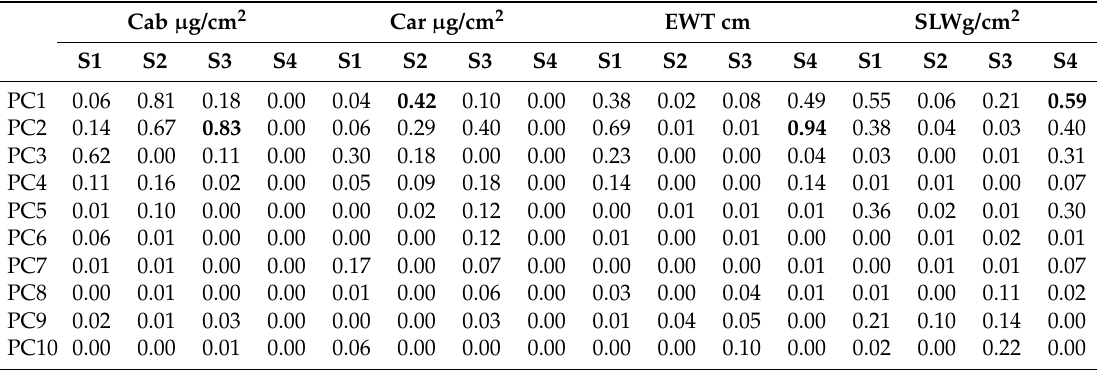
Table 4. The coefficients of determination between the weighting coefficients of the principal components (PCs) and the leaf biochemical contents of the training dataset for the spectral regions